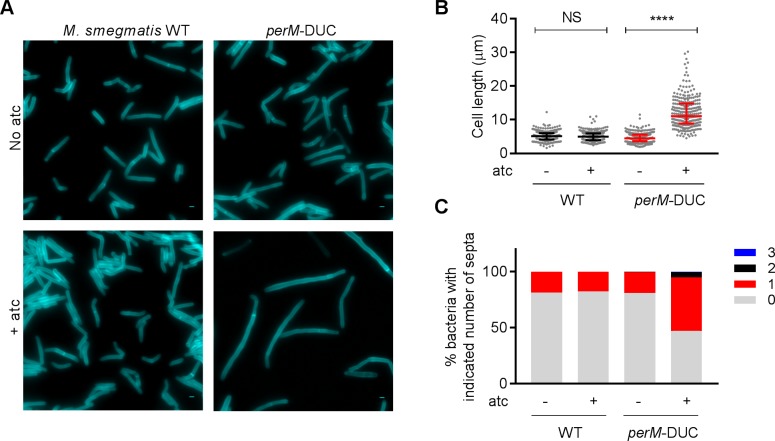
Depletion of PerM leads to a septation defect in M. smegmatis.(A) Representative microscopy images of WT M. smegmatis and the perM-DUC mutant after 9 hr of incubation in 7H9 medium supplemented with 1 mM HADA and in the absence or presence of 200 ng/ml atc. Scale bar, 1 µm. (B) Scatter plots of bacterial cell length of M. smegmatis strains from (A). The middle lines represent the medians and the top and bottom lines represent the 25th and 75th percentiles. P-values were computed using Kruskal-Wallis test and adjusted for multiple comparisons. ****, adj-P <0.0001. (C) Quantification of bacterial cells that contain 0, 1, 2 or 3 septa of M. smegmatis strains from (A). Data in (A–C) are representative of two independent experiments.
Figure 2—source data 1.Summary statistics of Figure 2B.